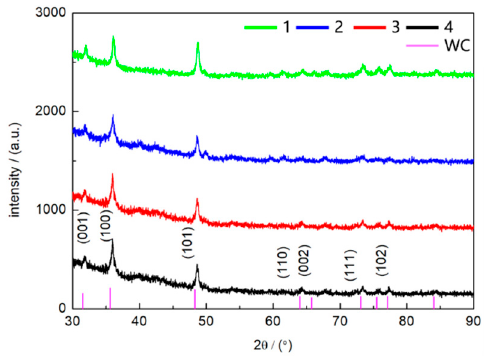
Figure 7. The XRD patterns of four groups of cemented carbides.